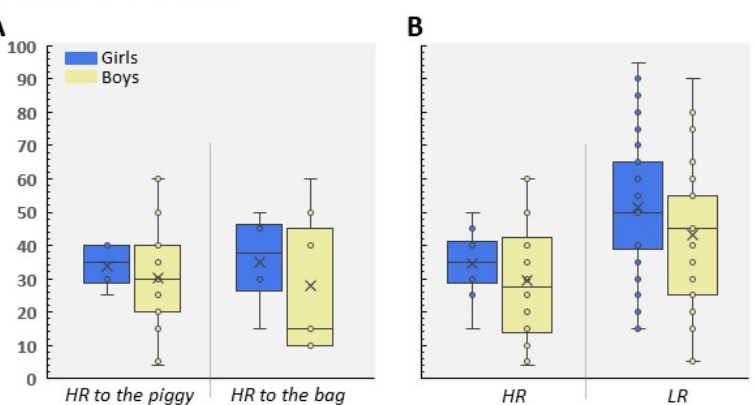
Figure 7. ( A ) Mean of gender-specific attention scores in the HR groups to the piggy and bag. ( B ) Distribution of attention by gender and LR and HR groups.